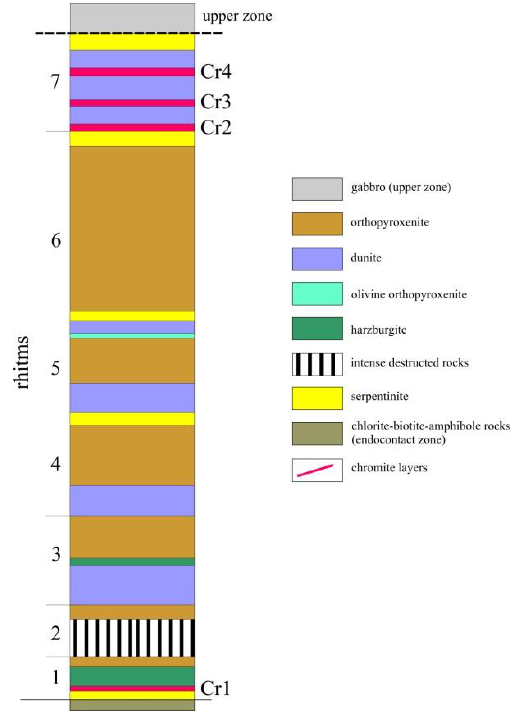
Figure 4. A generalized column, after [43,72].